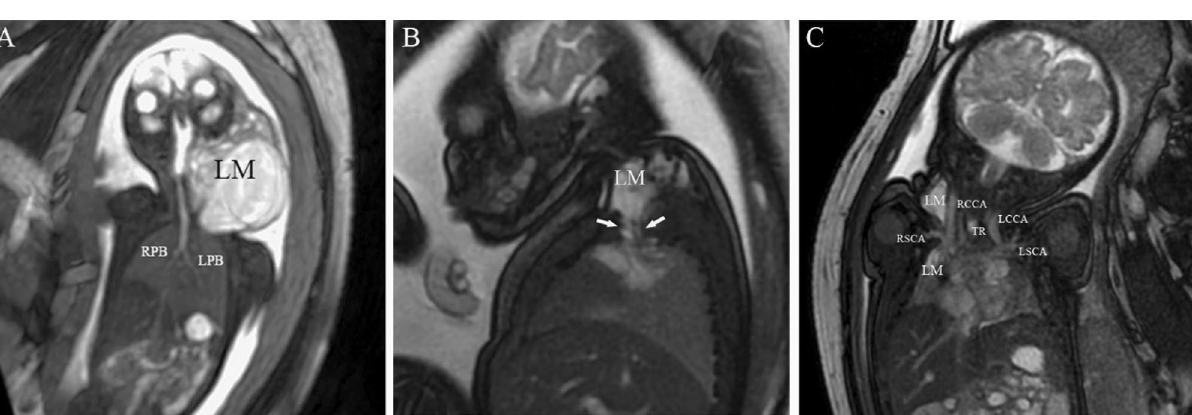
Figure 6. Two cases of lymphangioma (LM). ( A ) A case of LM at 26 weeks of gestational age (GA), the curved planar reformation of fast imaging employing steady-state acquisition (FIESTA) image showed high signal intensities of multilocular septum. The airway was filled with amniotic fluid showing a high signal, while the nasopharynx, laryngopharynx, trachea, and left primary bronchi (LPR) and right primary bronchi (RPR) were clearly displayed on level one. ( B ) For the fetus of LM at 35 weeks of GA, sagittal T2WI exhibited high signal cystic mass protrusions into the thoracic cavity from the right posterior triangle. ( C ) The coronal FIESTA image was same fetus as panel B, and showed a clear understanding of the relationship and anatomy of the region. RCCA = right common carotid artery, LCCA = left common carotid artery, RSCA = right subclavian artery, LSCA = left subclavian artery, TR =